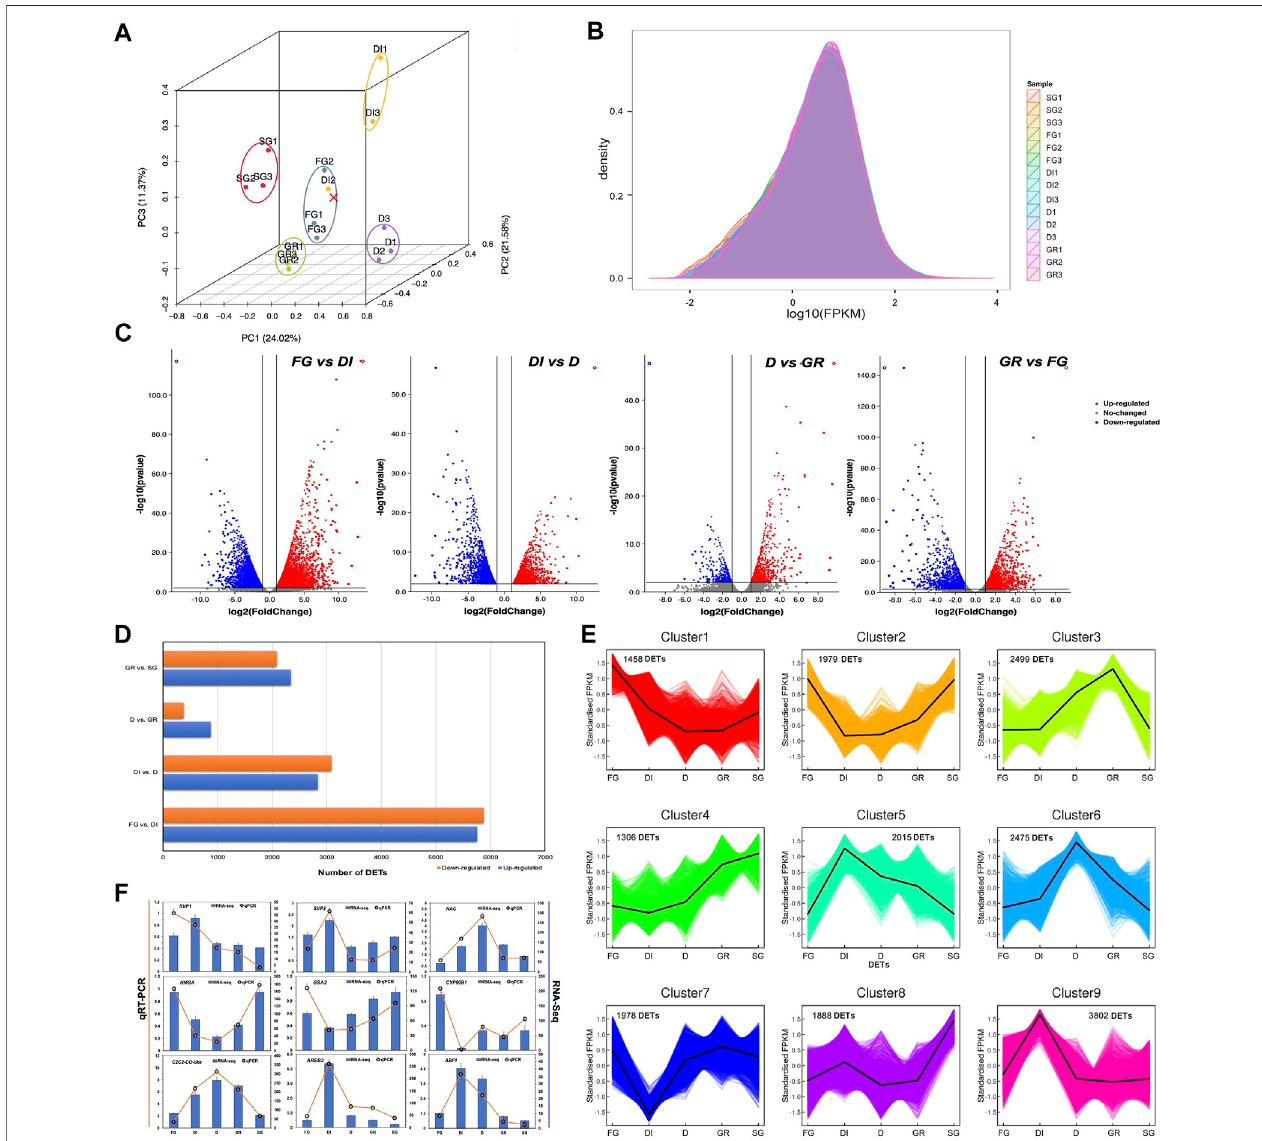
FIGURE 2 | Quality assessment and comparisons of transcriptome data between every two adjacent developmental groups of Japanese iris. (A) The principal component analysis (PCA) plot of the samples. The plot depicts the clustering patterns of the samples according to the developmental stages related to winter dormancy. In the diagram, the x -, y - and z -axis represent the fi rst, second and third principal components. The different colors represent the developmental stages of sampling.FGrepresentsfallgrowth.DIrepresentsdormancyinduction.Drepresentsdormancy.GRrepresentsgrowthrecovery.SGrepresentsspringgrowth. (B) Thegeneexpressiondensityofthesamples.The x -axisrepresentslog 10 (FPKM)ineachsample.The y -axisrepresentsthedensityofgeneexpressionineachsample. (C) Distributionofdifferentiallyexpressed transcripts(DETs)betweeneverytwoadjacentdevelopmentalgroupsofJapaneseiris.Thedownregulated andupregulatedDETs are high-lighted in blue and red, respectively. (D) The number of DETs between every two adjacent developmental groups. The x -axis represents the number of DETs. The y -axis represents thefour pairs ofcomparisons. (E) Dynamic geneexpression patterns of all DETsby thek-means clustering analysis. The x -axis representsthe fi ve developmental stages ofsampling. The y -axis represents the normalized gene expression from RNA-Seq. (F) Validation ofdifferential expression ofnine genes from real time qPCR (RT-qPCR) and RNA-Seq. The x -axis represents the fi ve developmental stages of sampling. The left y -axis represents the gene expression from RT-qPCR and the right y -axis represents the gene expression from